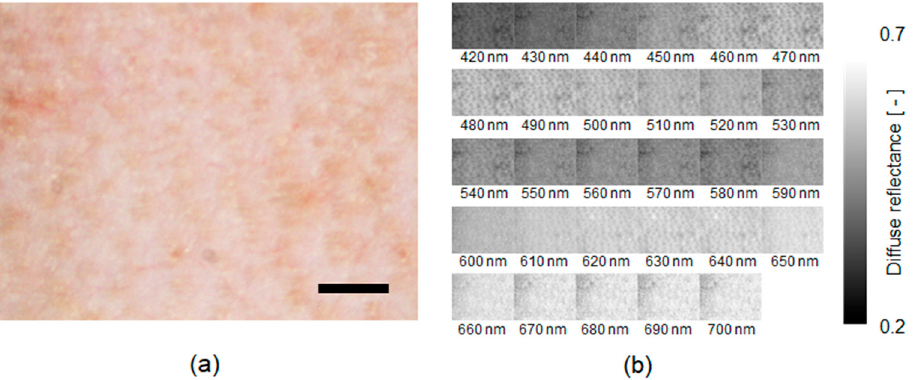
Figure 2. Typical results obtained from in vivo rat dorsal skin under normal conditions: ( a ) raw RGB image and ( b ) estimated images of spectral diffuse reflectance by Wiener estimation. A scale bar (black line in the RGB image) indicates 1.0 mm.